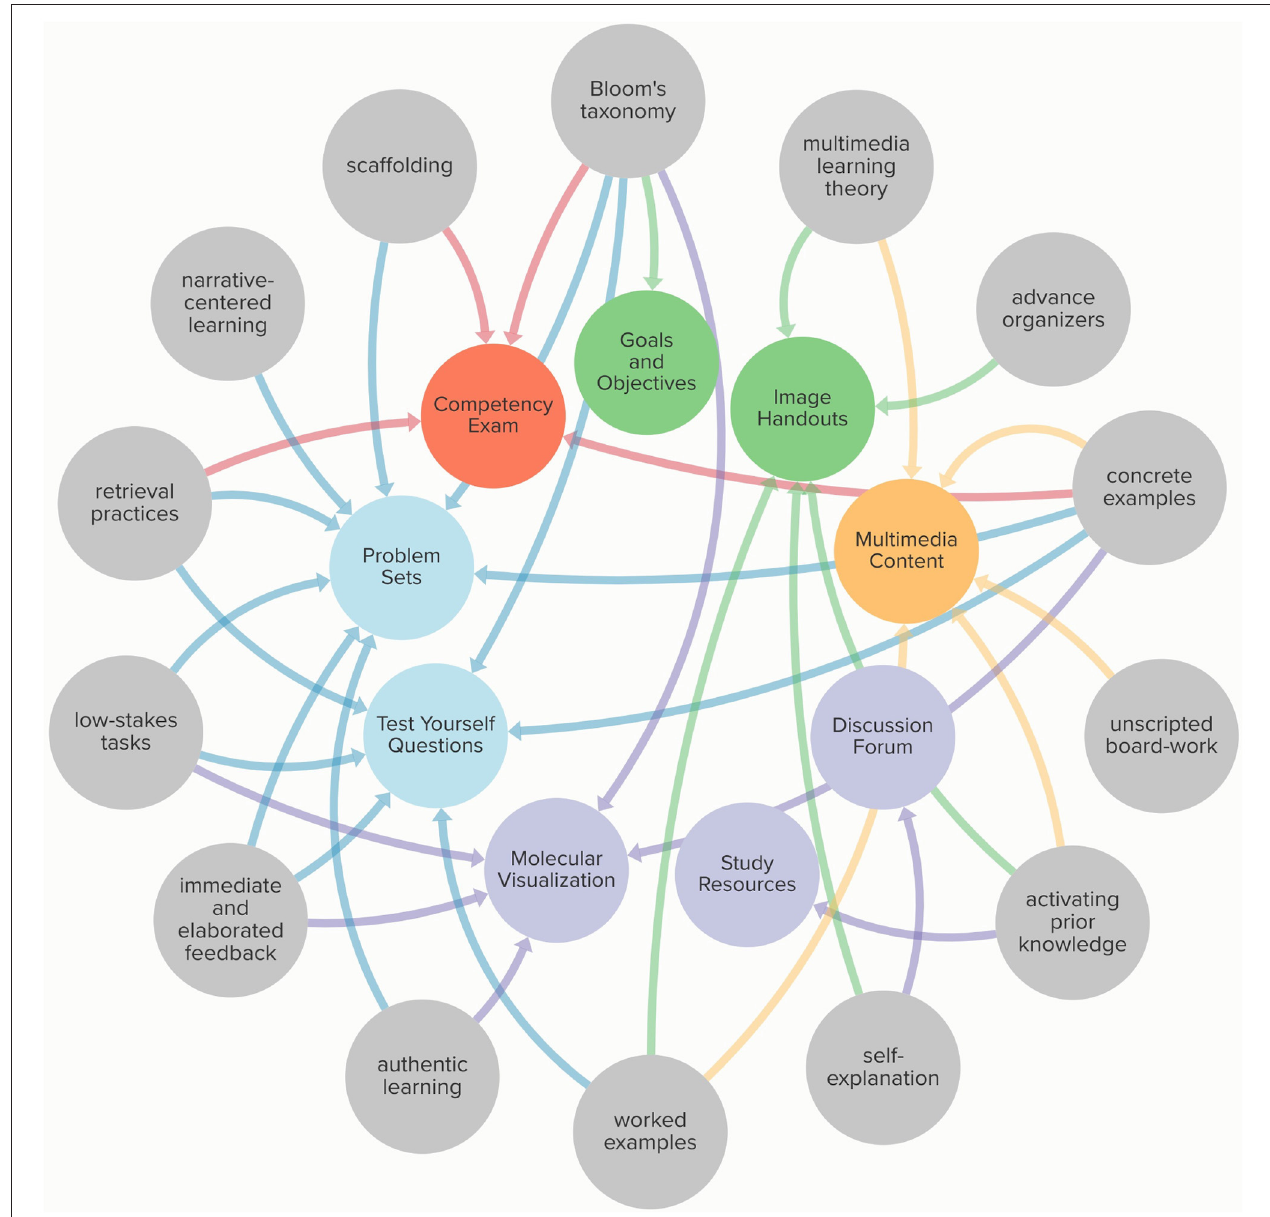
FIGURE 1 | A mapping of evidence-based practices stemming from the learning sciences (gray outer nodes) to course assets (colorful inner nodes). The course assets are color-coded by function: green = pre-instruction, yellow = multimedia, purple = supporting resources, blue = formative assessments, and orange = summative assessment. To explore this figure as an interactive visualization, please visit